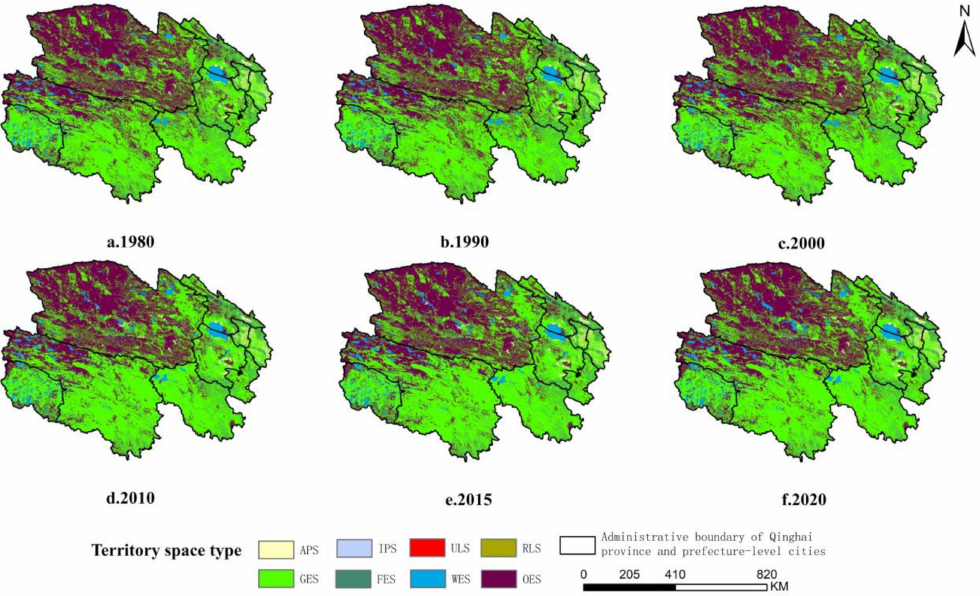
Figure 3. Territorial spatial pattern from the perspective of Production-Living-Ecological space for the years ( a ) 1980; ( b ) 1990; ( c ) 2000; ( d ) 2010; ( e ) 2015; ( f )